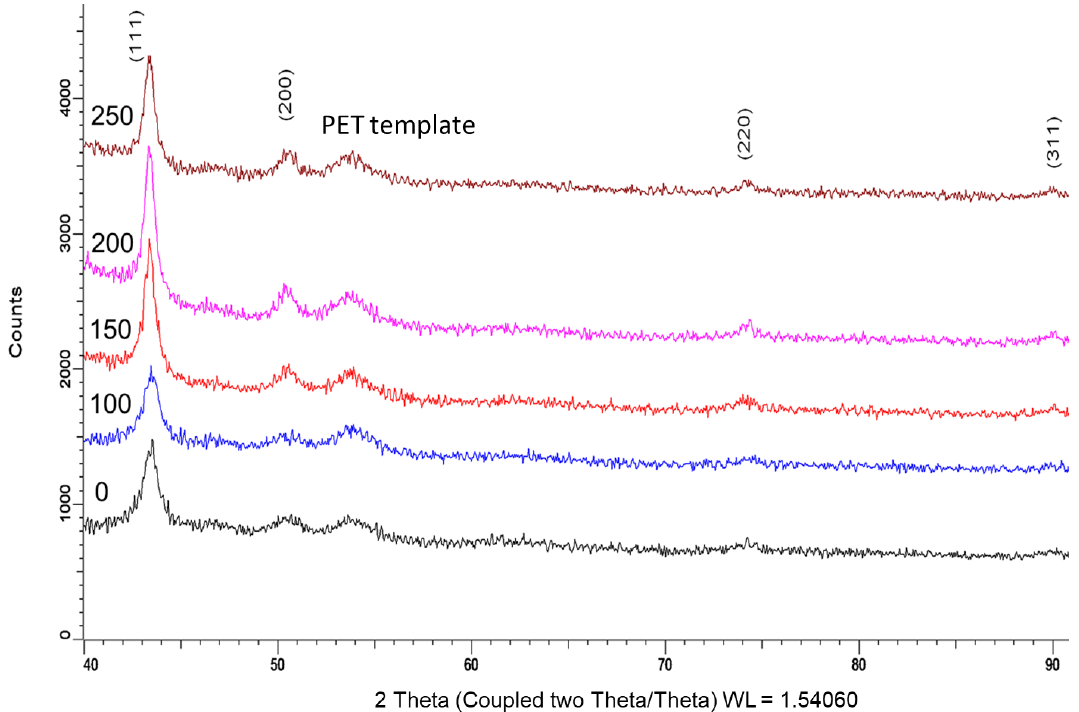
Figure 2. X-ray di ff raction (XRD) patterns of composite membranes at various e-beam Figure 2. X-ray diffraction (XRD) patterns of composite membranes at various e-beam doses.